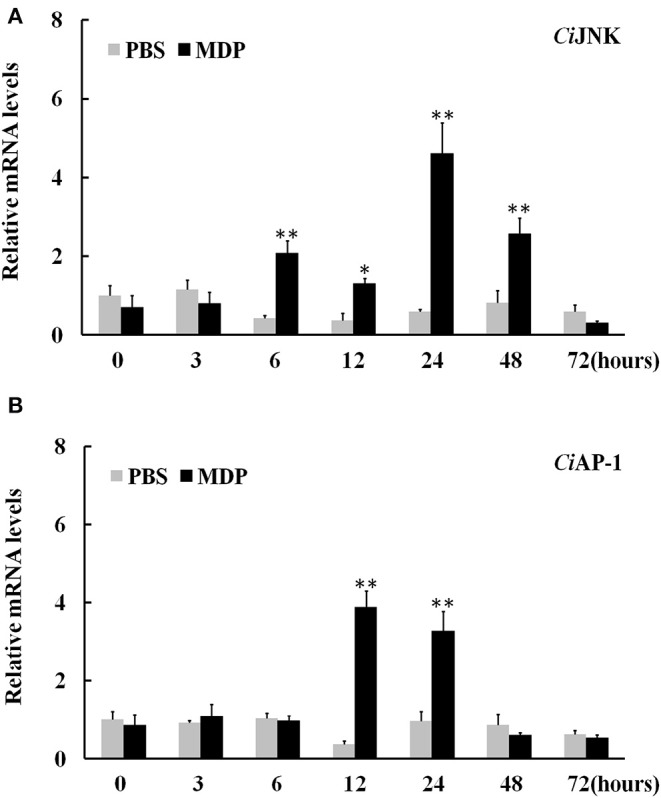
Relative expression of intestinal CiJNK (A) and CiAP-1 (B) in response to MDP challenge. The grass carp β-actin gene was used as a reference gene to normalize the expression level. Comparative analysis and statistical tests were performed on the challenge groups and PBS group at the same time point. Each bar represents the mean of the normalized expression levels of replicates (N = 3); significant differences are indicated by an asterisk (* and ** represent P < 0.05 and P < 0.01, respectively).